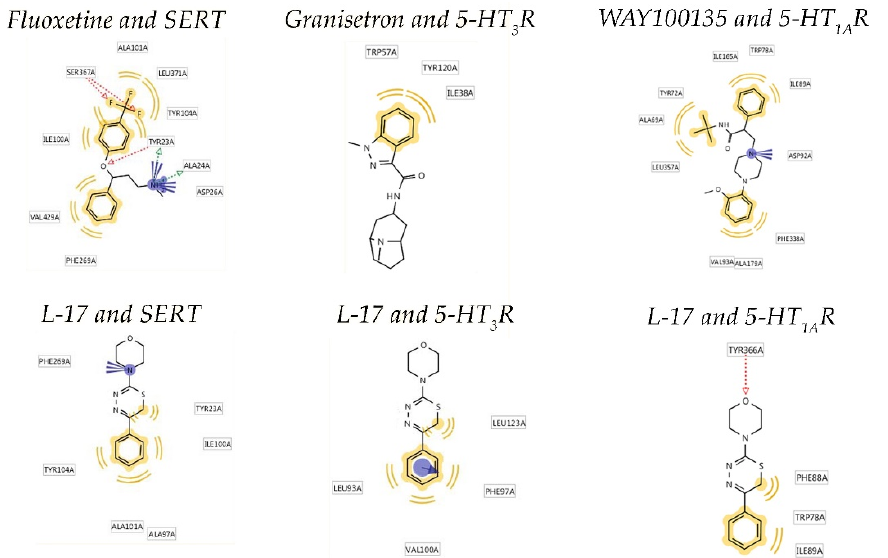
Figure 2. Binding of L-17, fluoxetine, granisetron, and WAY100135 to the SERT, and 5-HT 3 (5-HT 3 R) and 5-HT 1A (5-HT 1A R) receptors.